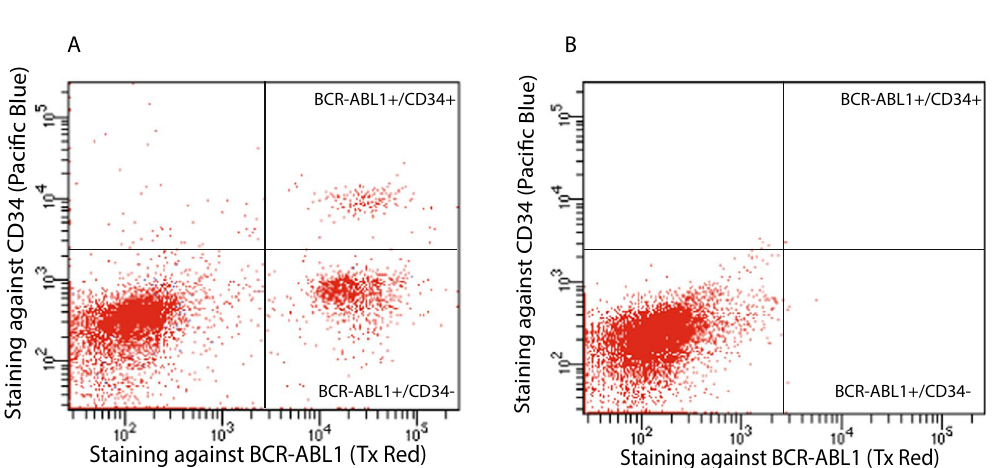
Figure 7. Simultaneous staining of CML cells for BCR-ABL1 and for CD34. ( A ) The image displays simultaneous immunofluorescence staining for CD34 during BCR-ABL1 PLA-flow in a newly diagnosed CML patient. Three distinct populations were observed: A major population negative for both BCR-ABL1 and CD34, one subpopulation (13.8%) expressing BCR-ABL1 but not CD34, and one subpopulation (1.8%) positive for both CD34 and BCR-ABL1. ( B) The same experiment was performed on a healthy individual as a negative control. The X-axes represent intensity of staining against BCR-ABL1 and the Y-axes reflect the CD34